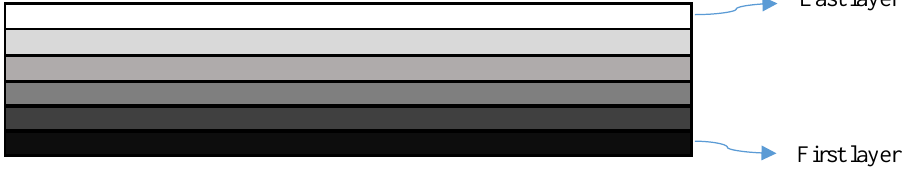
Figure 7. Discretized 4D-printed sample.